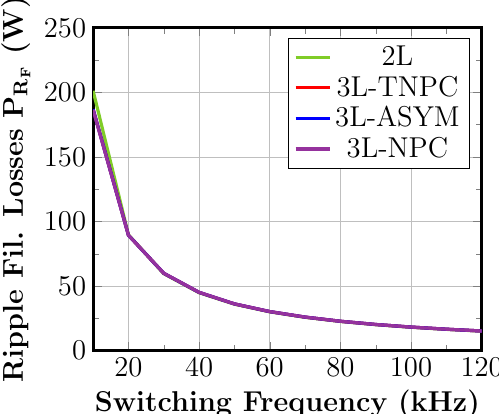
Figure 16. Ripple filter losses as function of the switching frequency. The ripple filter is tuned at half of the switching frequency at each case maintaining the capacitor value fixed at 350 µ